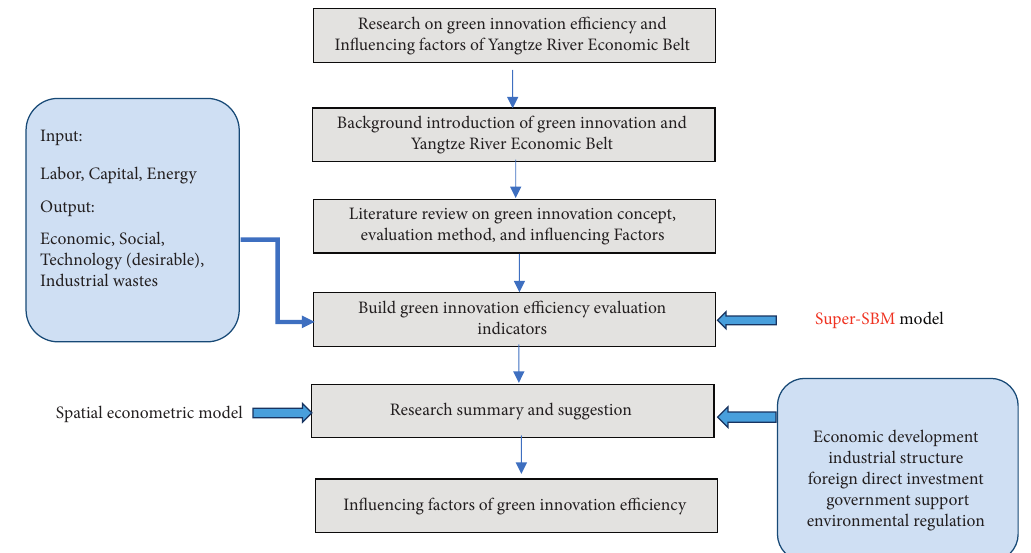
Figure 1: Article